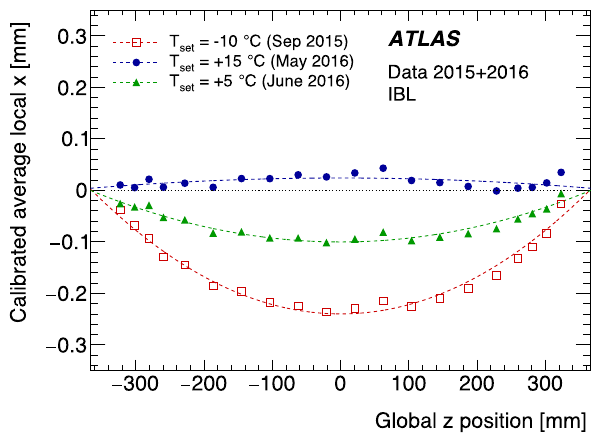
Fig. 7 IBLlocal- x positioninthetransverseplaneaveragedoverall14 IBL staves for 2015 data using T set = − 10 ◦ C (red open squares), and for 2016 data using different T set ( + 15 ◦ C, solid blue circles; + 5 ◦ C, solid green triangles). No error bars associated with data are shown. The IBL distortion was constant during all three LHC fills. Here, only the correction due to the IBL distortion is shown. The baseline, which describes the overall translation of the whole stave, is subtracted using Eq. (21). The fit represents only a first-order correction. Additional corrections are computed as part of the detailed alignment corrections at a later stage